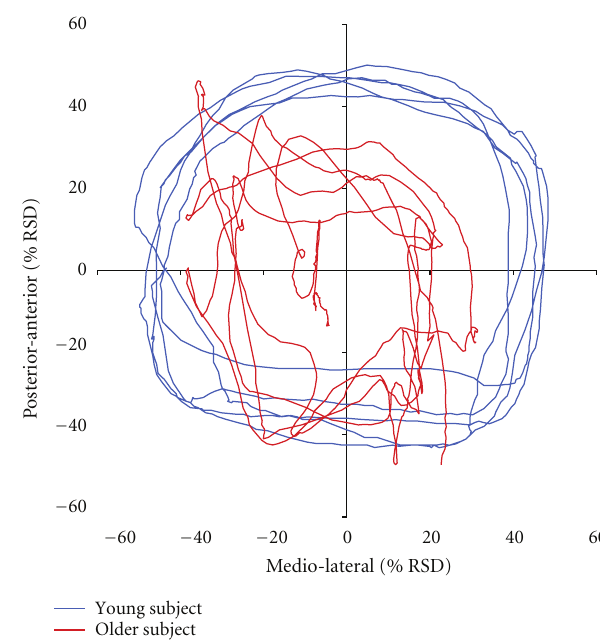
Figure 2: Single-subject data of a young subject (32 years; blue line) and an older subject (74 years; red line) depicted as statokinesigram for subtest 8. COP deviations are given in percent changes of raw sensor data (% RSD). Subjects were asked to perform clockwise rotational movements and thereby try to displace their COP maximally without losing balance.